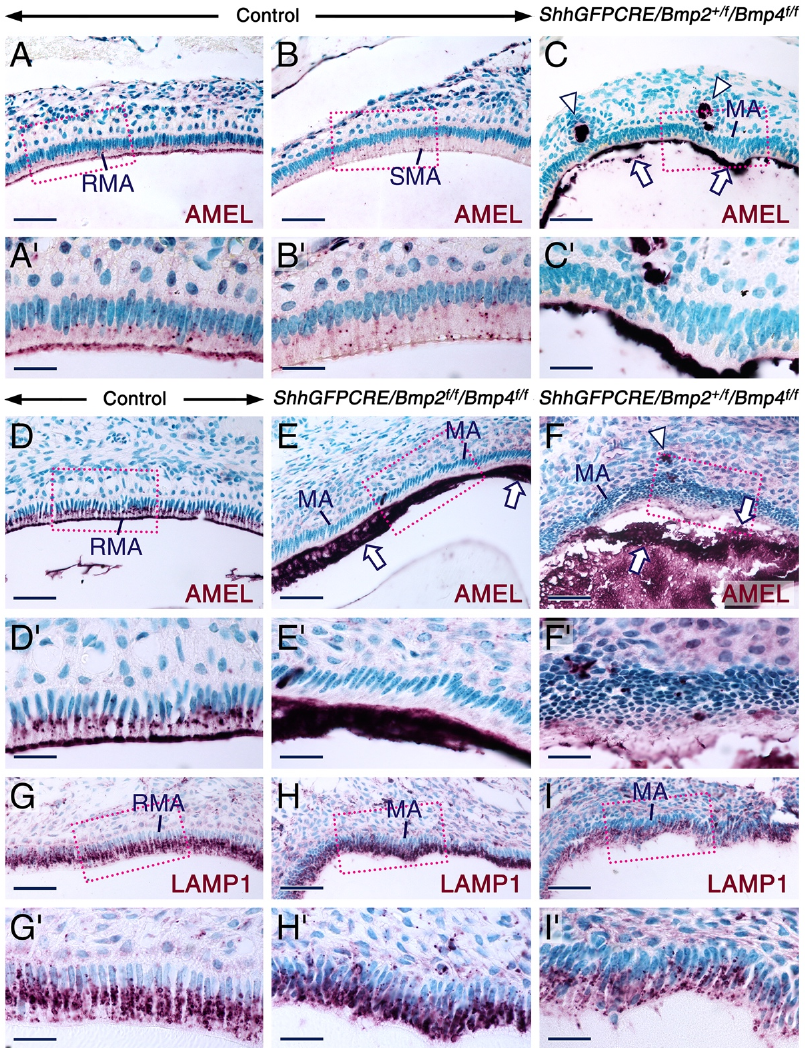
Figure 1. Combined loss of BMP2 and BMP4 signaling in the dental epithelium causes abnormal enamel maturation and aberrant development of maturation-stage ameloblasts. ( A – I ) Sections across incisors ( A – C ) and molars ( D – I ) at the level of maturation-stage of amelogenesis from adult ( A – C ) and 12 days postpartum ( D – I ) control ( A , B , D , G ), ShhGFPCRE/Bmp2 +/f /Bmp4 f/f ( C , F , I ) and